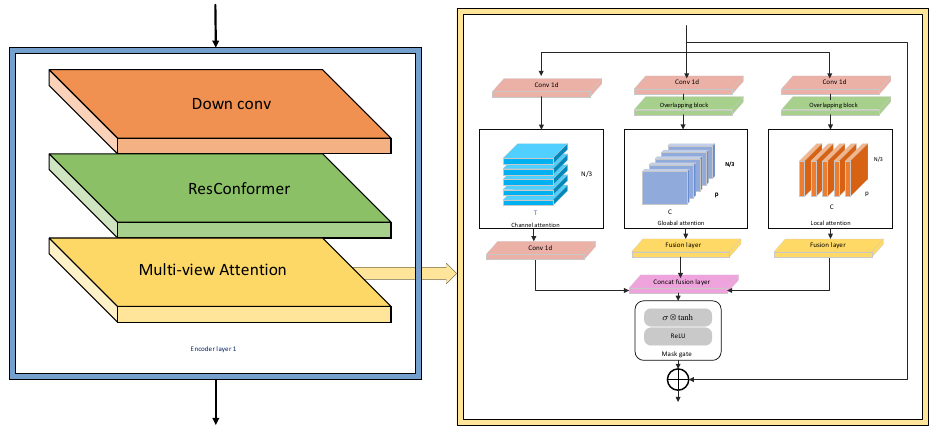
Figure 1. Structure of encoder and MA module.